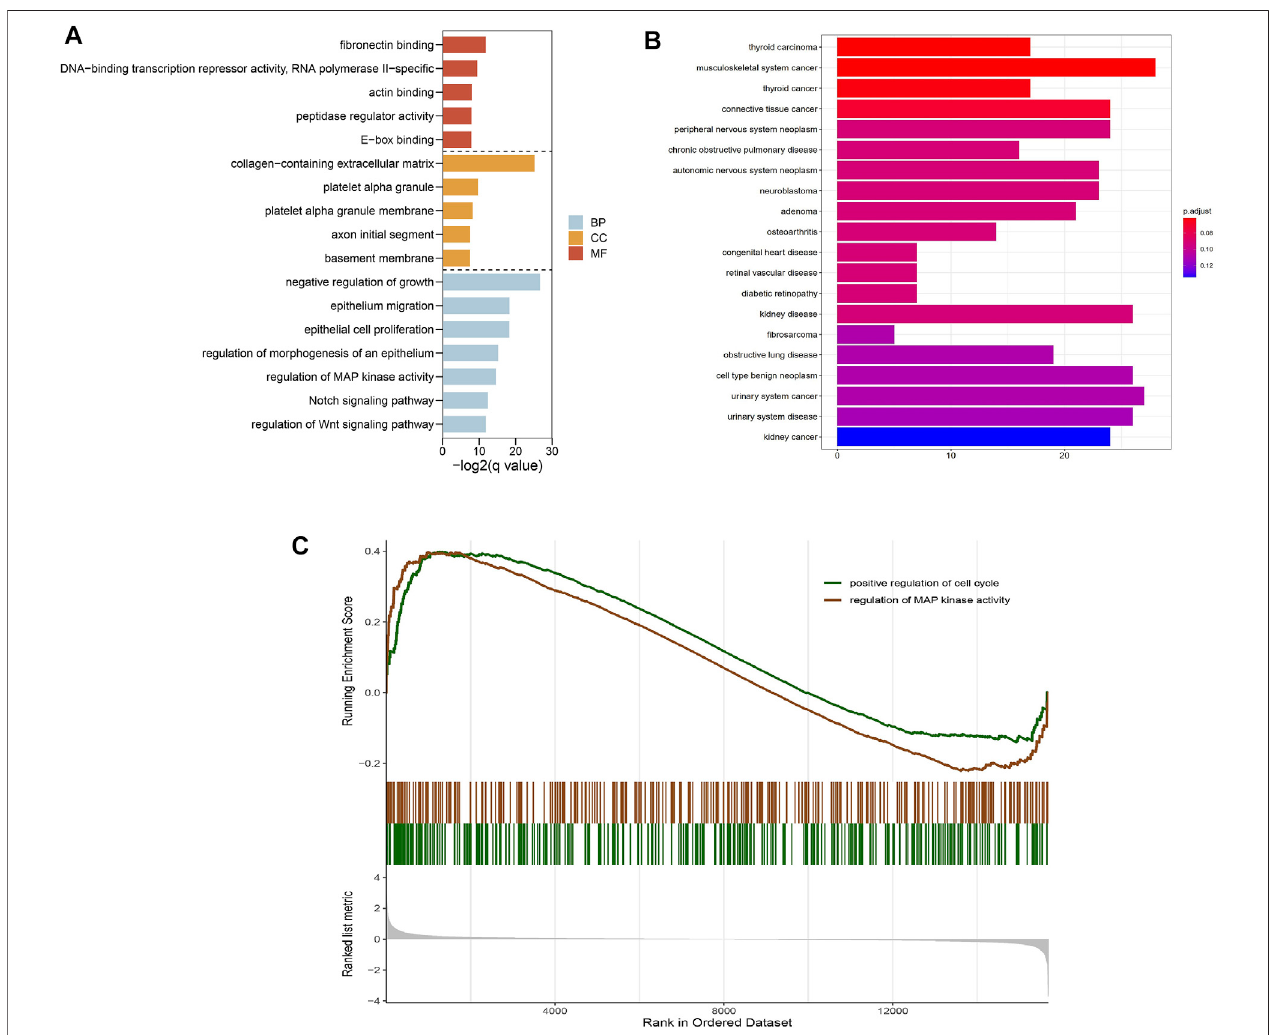
FIGURE 4 | GO enrichment of DEGs and GSEA enrichment analysis for all gene expression matrix. (A) GO enrichment analysis, where the horizontal axis represents the number of DEGs under the GO term. (B) DO enrichment analysis, where the horizontal axis represents the number of DEGs under the DO term. (C) Two pathways including positive regulation of cell cycle and regulation of MAP kinase activity were signi fi cantly enriched by the GSEA analysis.